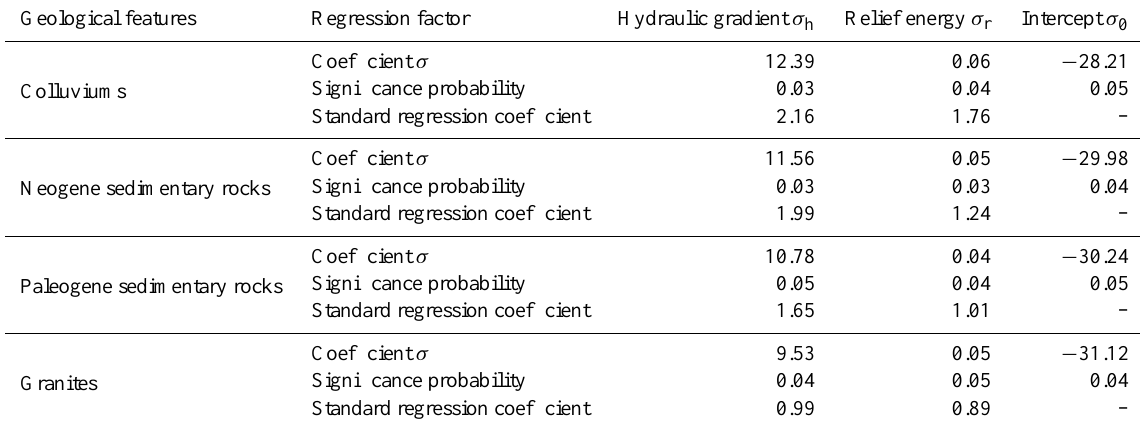
Table 3. Summary of the results of the multiple logistic regression analysis. Geological